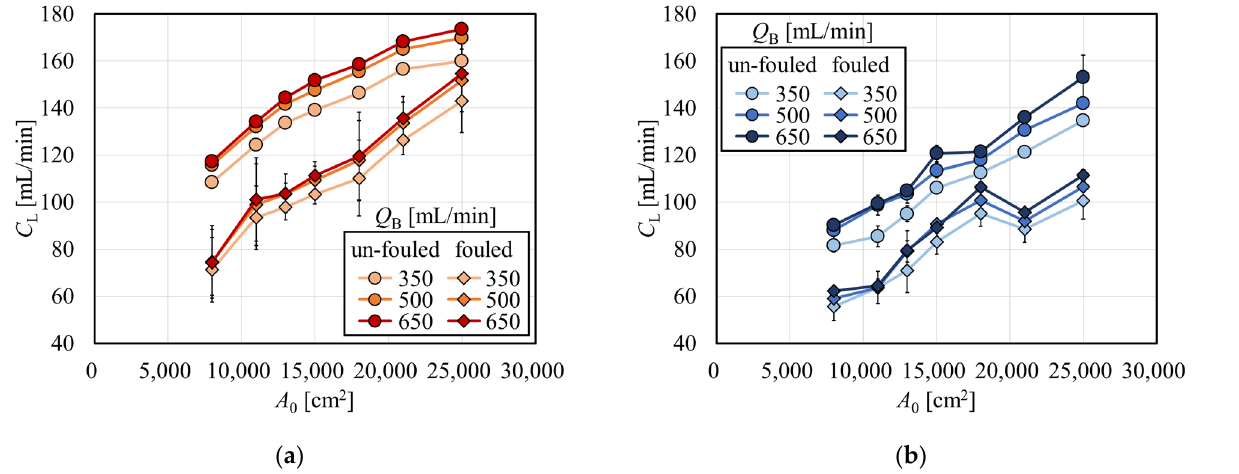
Figure 7. Clearance for ( a ) vitamin B 12 and ( b ) inulin in APS-SA series ( Q D = 500 mL/min, n = 3).